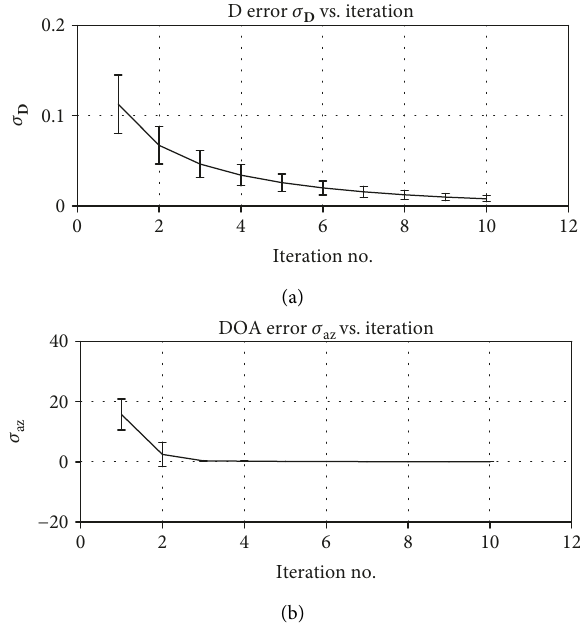
Figure 6: The error in D and the DOAs as a function of the iteration number. The azimuth standard deviation 𝜎